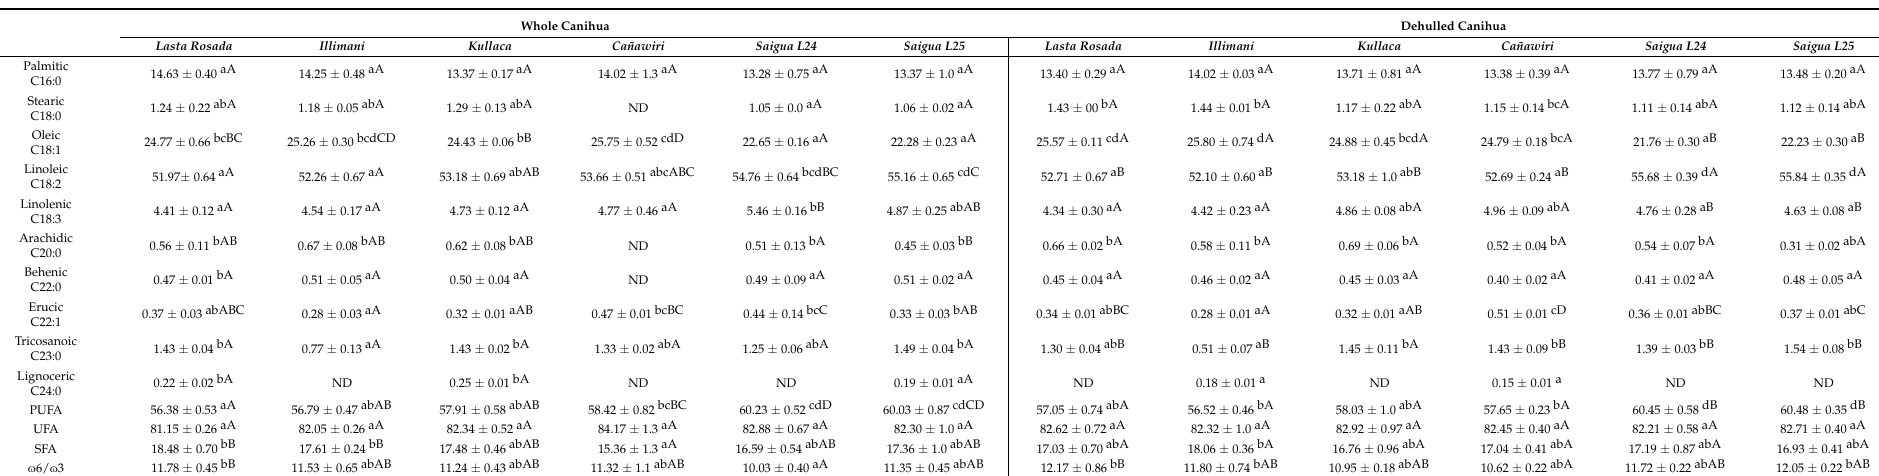
Table 4. Fatty acid composition of canihua ( Chenopodium pallidicaule ) cultivars. All values [%] are presented in dry weight (dw), as mean ± standard deviation ( n = 3). For each compound, different superscript lowercase letters in rows indicate significant differences between canihua samples ( p < 0.05 ), and different uppercase letters indicate a significant difference between whole or dehulled grains ( p < 0.05